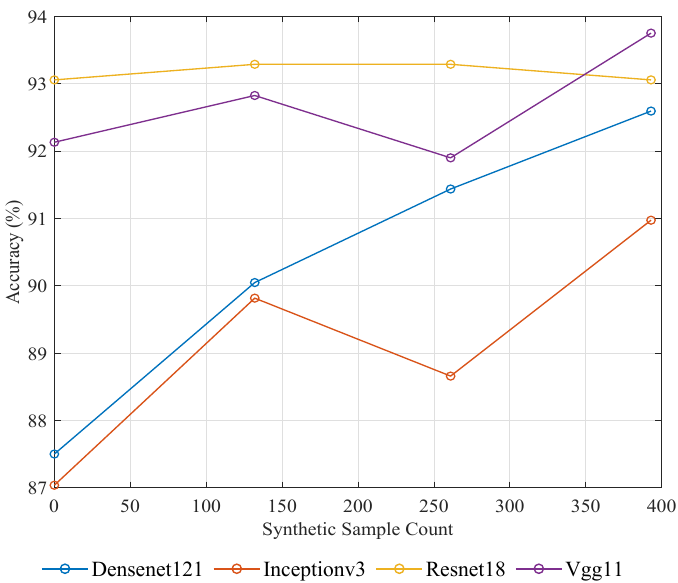
Figure 6. Accuracy of each network when altering the count of synthetic data within the training process. These results correspond to configurations C1, C2, C3, and